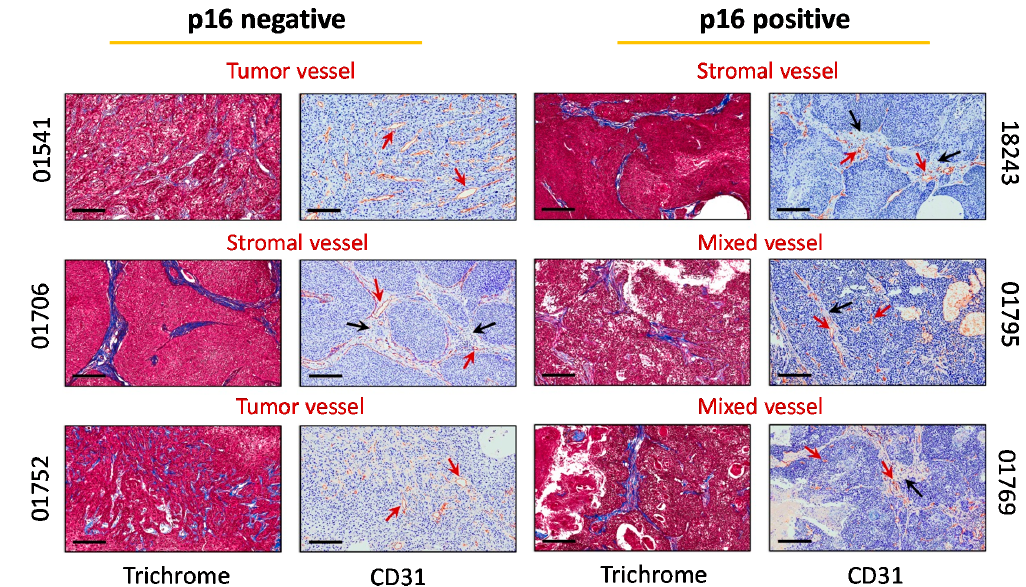
Figure 2. Stromal and vascular heterogeneity in PDX models of head and neck squamous cell carcinomas (HNSCC). Panel of images represent photomicrographs of Masson’s trichrome and CD31 stained tumor sections of the three p16-negative and the three p16+ PDX models of HNSCC. All images were captured at 20× magnification. Tumors were classified as tumor vessel (TV), stromal vessel (SV) or mixed phenotype based on the location and distribution of CD31+ vessels ( n = 4–5 fields per tumor section, n = 3–5 samples per xenograft type). Black arrows point to stroma and red arrows indicate CD31+ blood vessels. Images are shown at 20× magnification, scale bar represents 100 μ m.